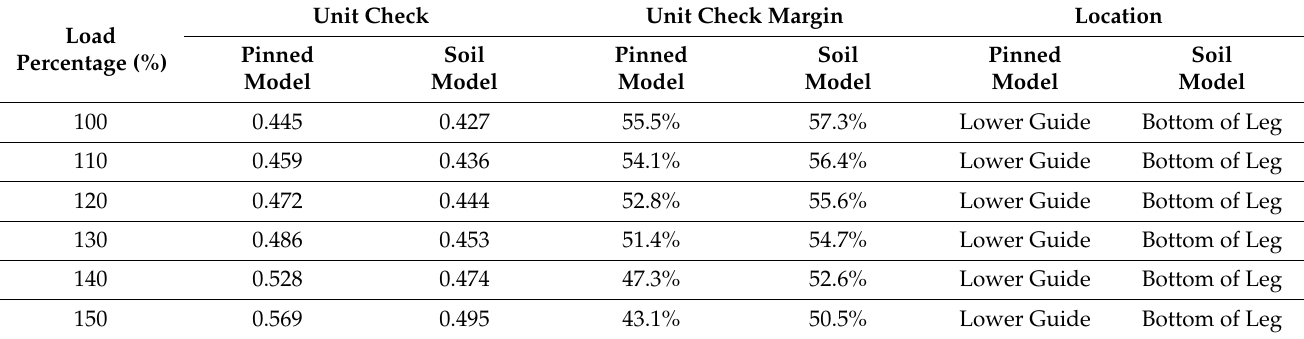
Table 7. Effect of structural response according to parameters for wind speed.